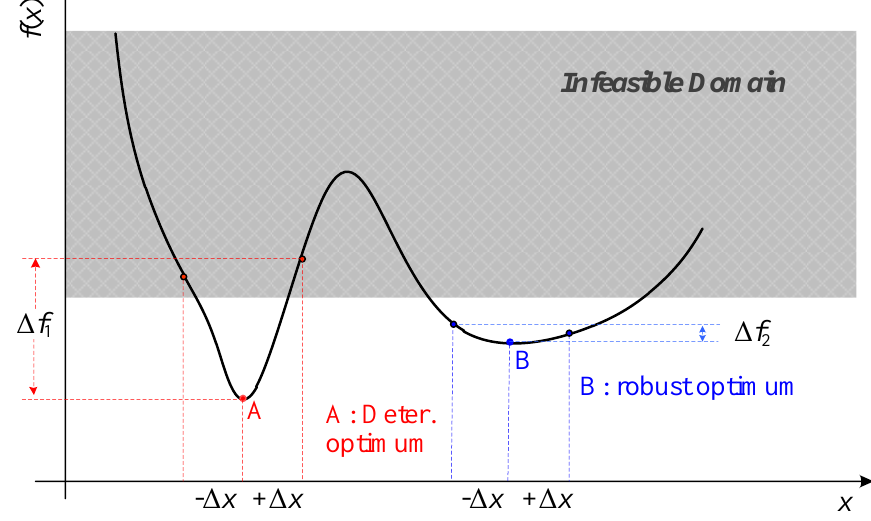
Figure 3. Illustrations of deterministic and robust optimums.